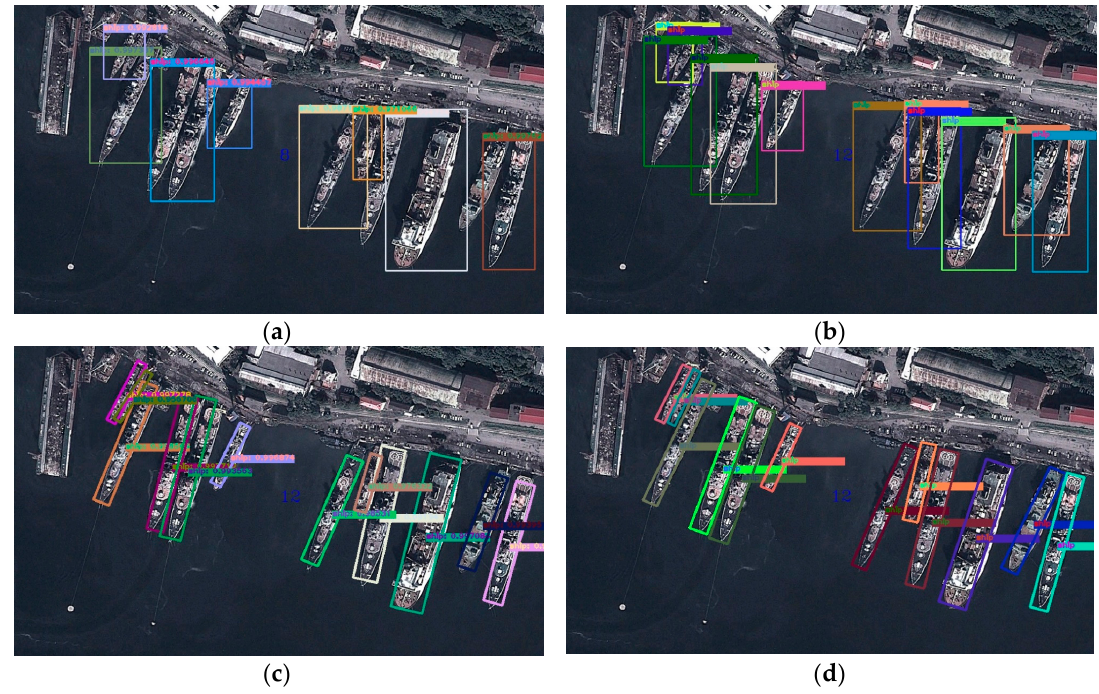
Figure 6. ( a ) Detection result of horizontal region detection (missed detections appear, due to the non-maximum suppression); ( b ) Horizontal ground-truth; ( c ) Detection result of rotation region detection; ( d ) Rotation ground-truth.